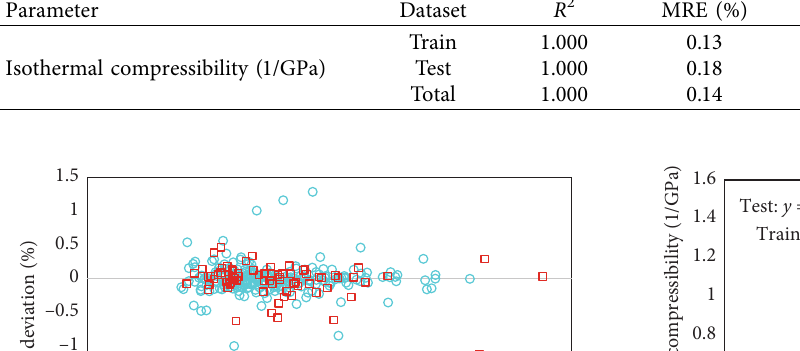
Table 1: Calculated values of statistical data in order to evaluate the target parameter using the ELM model. Parameter